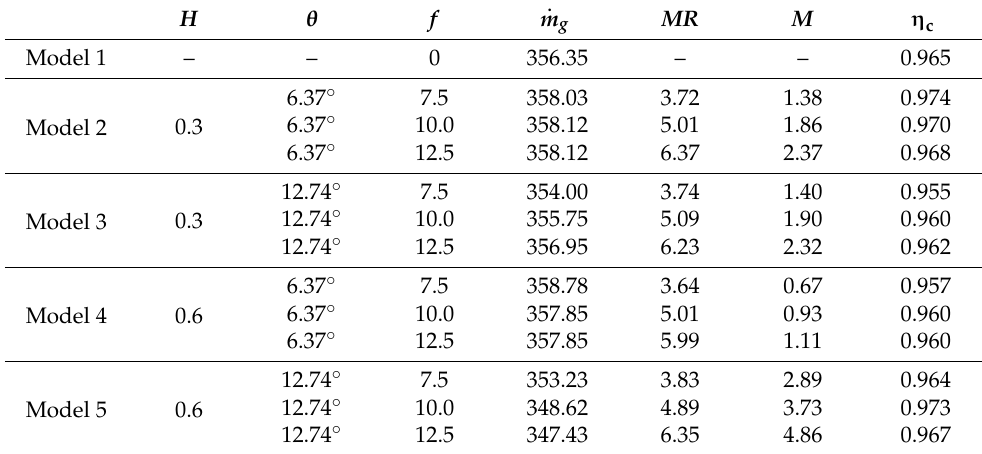
Table 4. Experimental design parameters and key